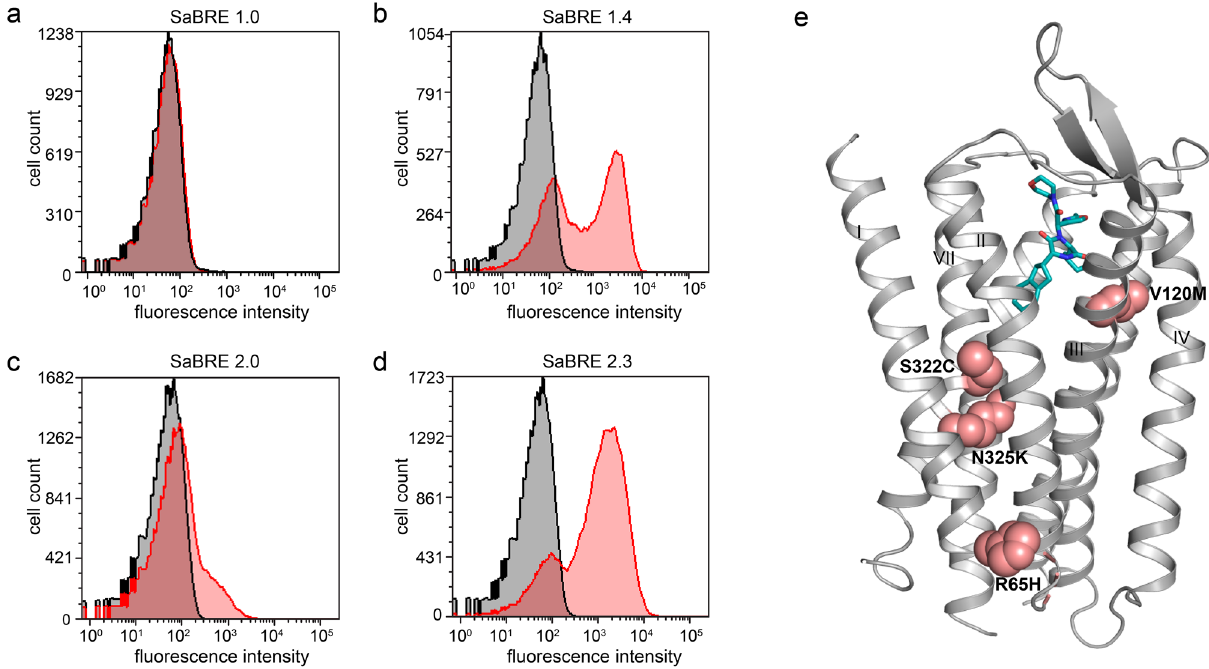
Figure 1. Identification of well-expressing OTR variants with SaBRE. ( a , b ) Histogram plots of fluorescent ligand binding data measured by flow cytometry. The total signal (red curves) and nonspecific signal (in the presence of unlabelled ligand, black curves) are shown for the starting pool SaBRE 1.0 ( a ) and the final pool SaBRE 1.4 ( b ) of the first round of SaBRE. ( c , d ) Histogram plots of fluorescent ligand binding flow cytometry data with total signal (red curves) and nonspecific signal (black curves) are shown for the starting pool SaBRE 2.0 ( c ) and the final pool SaBRE 2.3 ( d ) of the second round of SaBRE. ( e ) Mutations (pink spheres) of the single clone, OT-y01, identified in pool SaBRE 1.4, mapped on the OTR structure (grey, PDB ID: 6TPK) in complex with retosiban